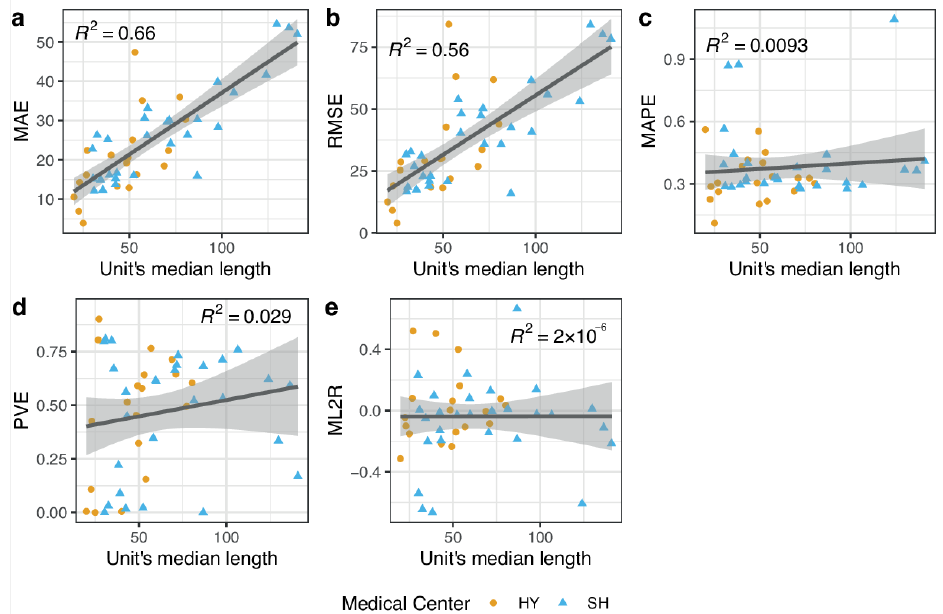
Figure 4. Average performance per surgery unit, by median surgery length. For each surgery unit, we computed the median surgery length and the average performance of the model in ( a ) MAE; ( b ) RMSE; ( c ) MAPE; ( d ) PVE, and ( e ) ML2R. ( b ) RMSE; ( c ) MAPE; ( d ) PVE, and ( e )